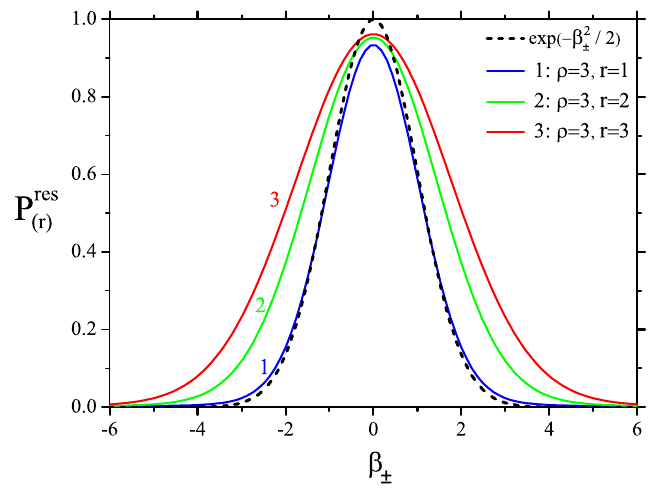
Figure 4. The resonant profile function for the first three